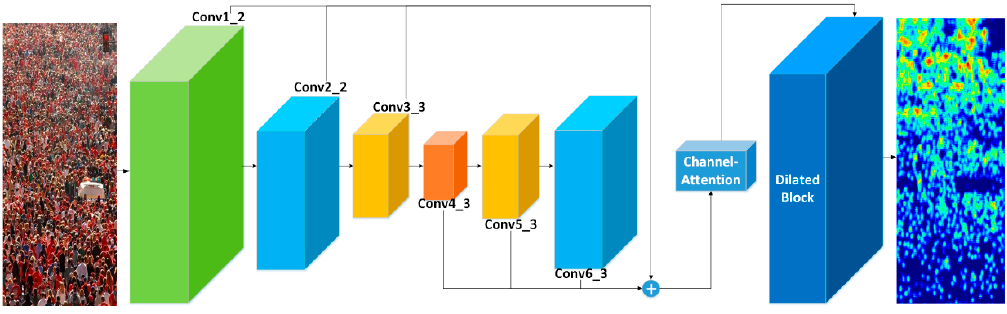
Figure 5. The architecture of the one-fusion framework.